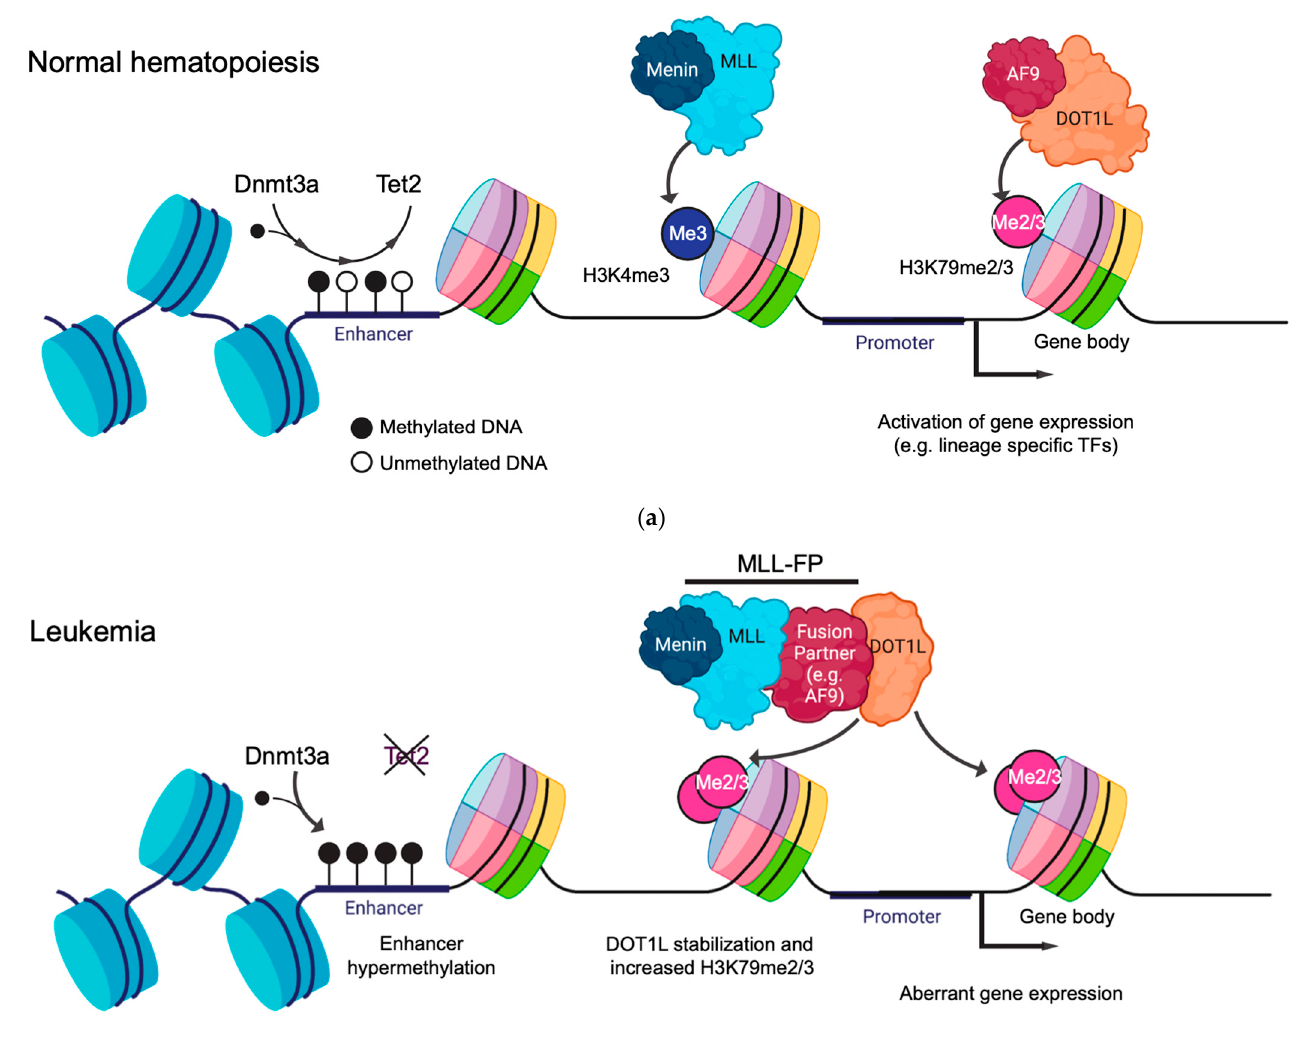
Figure 1. Mechanisms of epigenetic regulation in normal and leukemic hematopoiesis mediated by histone modifications and DNA methylation. ( a ) The de novo DNA methylation machinery dynamically regulates the methylation status of cis-regulatory elements, such as promoters and enhancers, to modulate gene expression. Epigenetic modifier proteins such as MLL or DOT1L catalyze histone methylation in the promoter (H3K4me3) and gene body (H3K79me2/3) regions, respectively, so as to promote gene expression. ( b ) During leukemogenesis, disruption of the DNA methylation machinery, such as TET2 loss of function, leads to the hypermethylation of enhancers and transcriptional repression. The fusion of epigenetic modifier proteins, such as MLL::AF9, results in the aberrant stabilization of DOT1L and elevated levels of H3K79me2/3, which drives abnormal gene expression signatures.